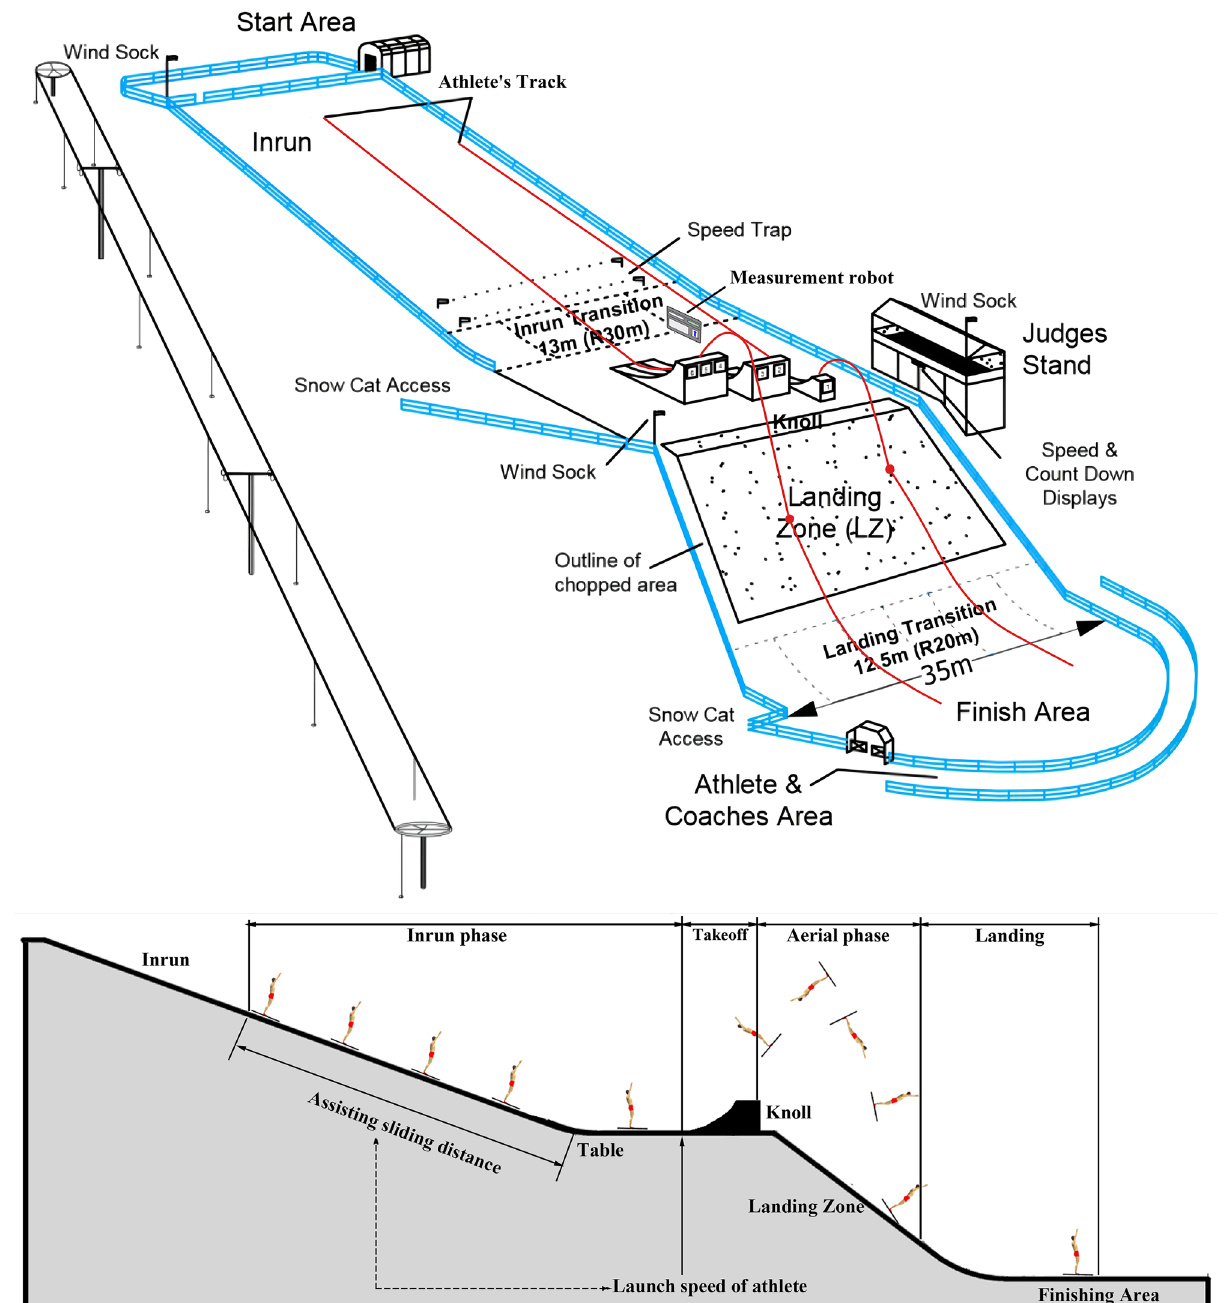
Figure 1. The diagram and side view of the aerial